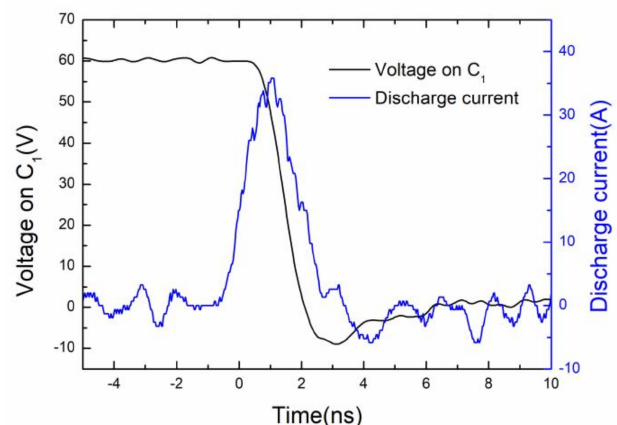
Figure 9. The voltage waveform on capacitor C 1 and the discharge current waveform obtained by differentiating the voltage